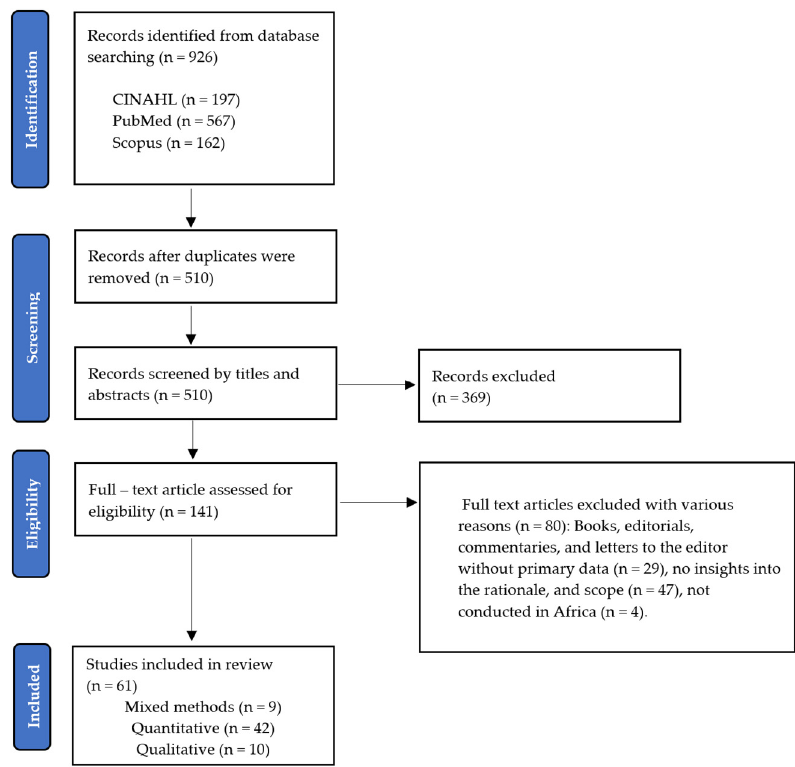
Figure 1. PRISMA-ScR flow diagram.